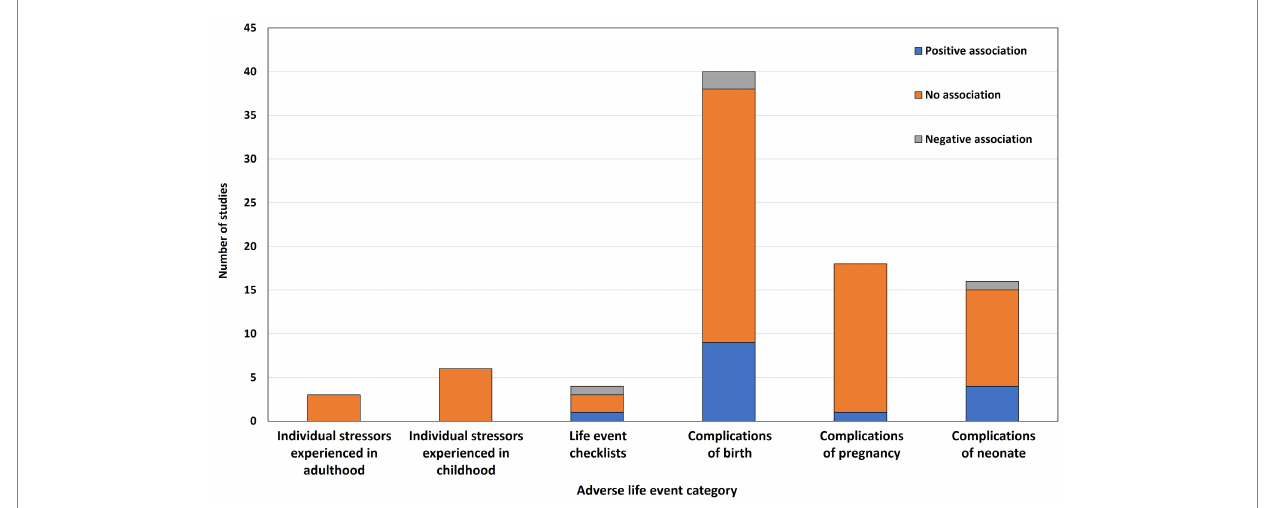
FIGURE 2 Frequency of reported associations across studies, grouped by type of adverse